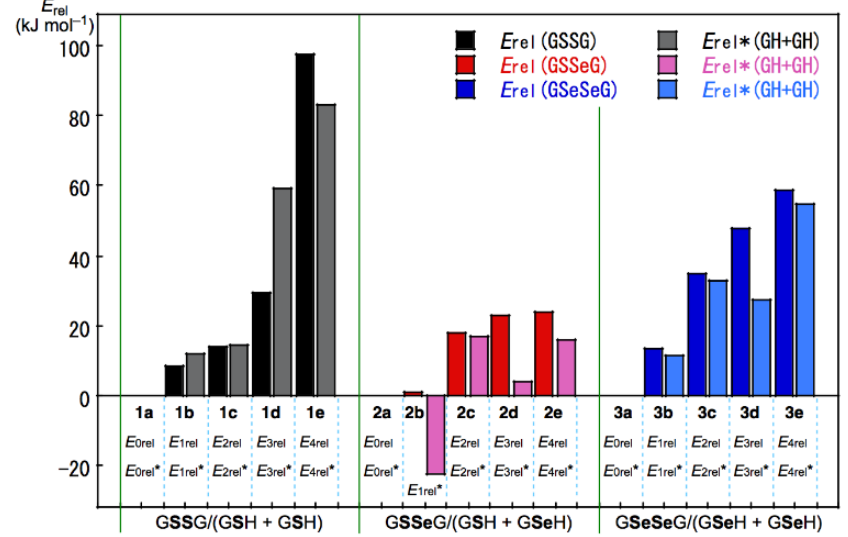
Figure 6. Plots of E rel of GEE’G and (2G − H + MeEE’Me) for 1a – e (GSSG), 2a – e (GSSeG) and 3a – e (GSeSeG), evaluated with M06-2X/BSS-A.